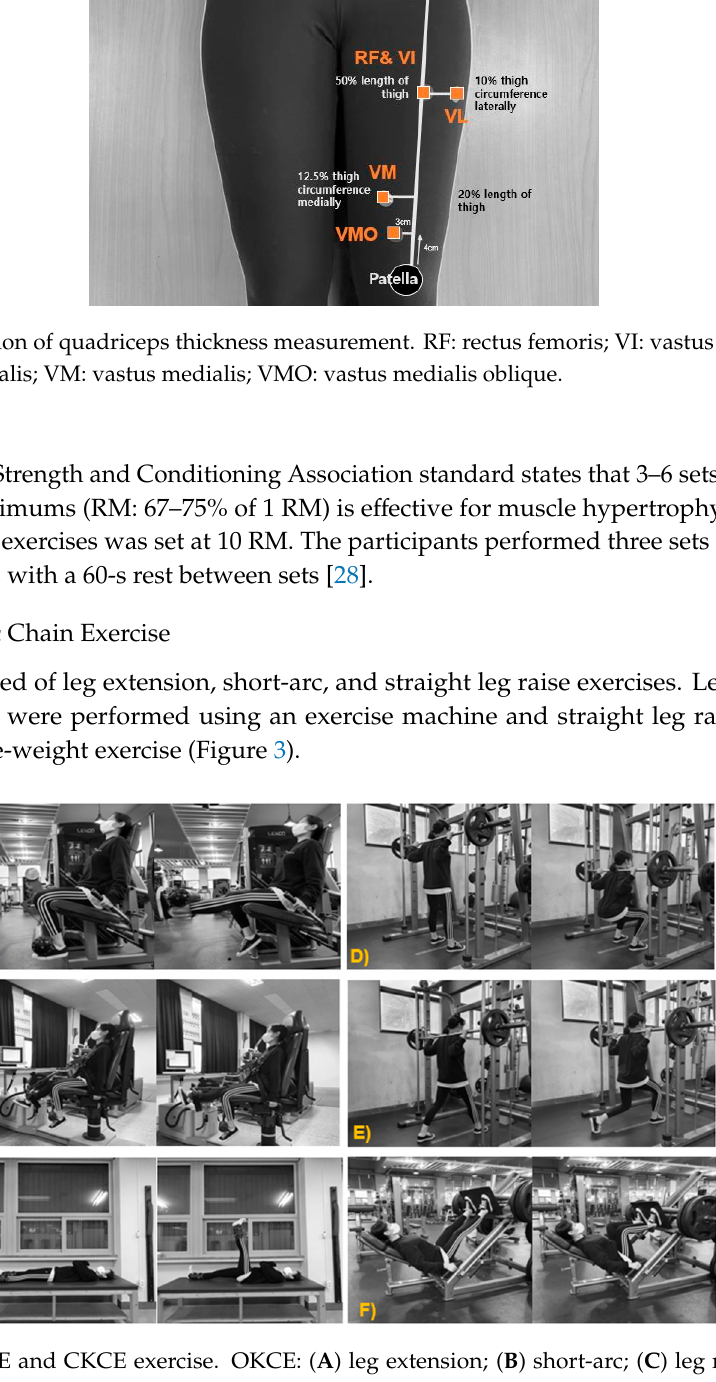
Figure 3. OKCE and CKCE exercise. OKCE: ( A ) leg extension; ( B ) short-arc; ( C ) leg raise. CKCE: ( D ) squat—Smith machine; ( E ) lunge—Smith machine; ( F ) leg